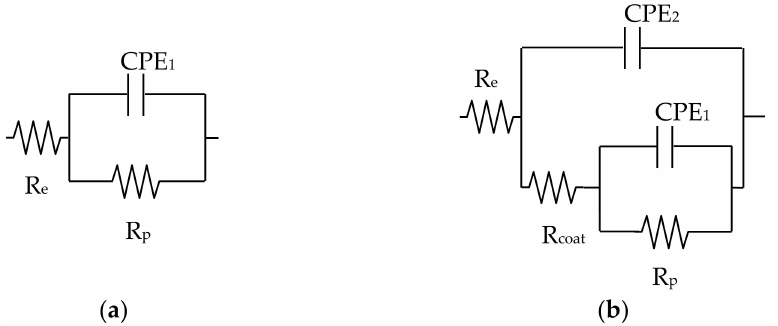
Figure 3. Equivalent circuits used for the fitting of the impedance response of CoCr, CoCrErGO, and CoCrErGOHA surfaces during testing times considering one constant time ( a ) and two con- stant times ( b